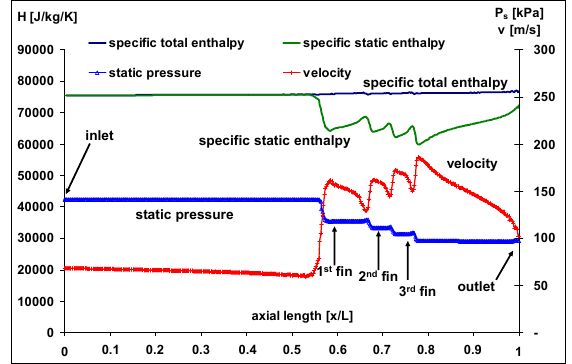
Figure 4. Variation of the Enthalpies, static pressure and velocity with the axial length of the labyrinth seal at 12 g/s.